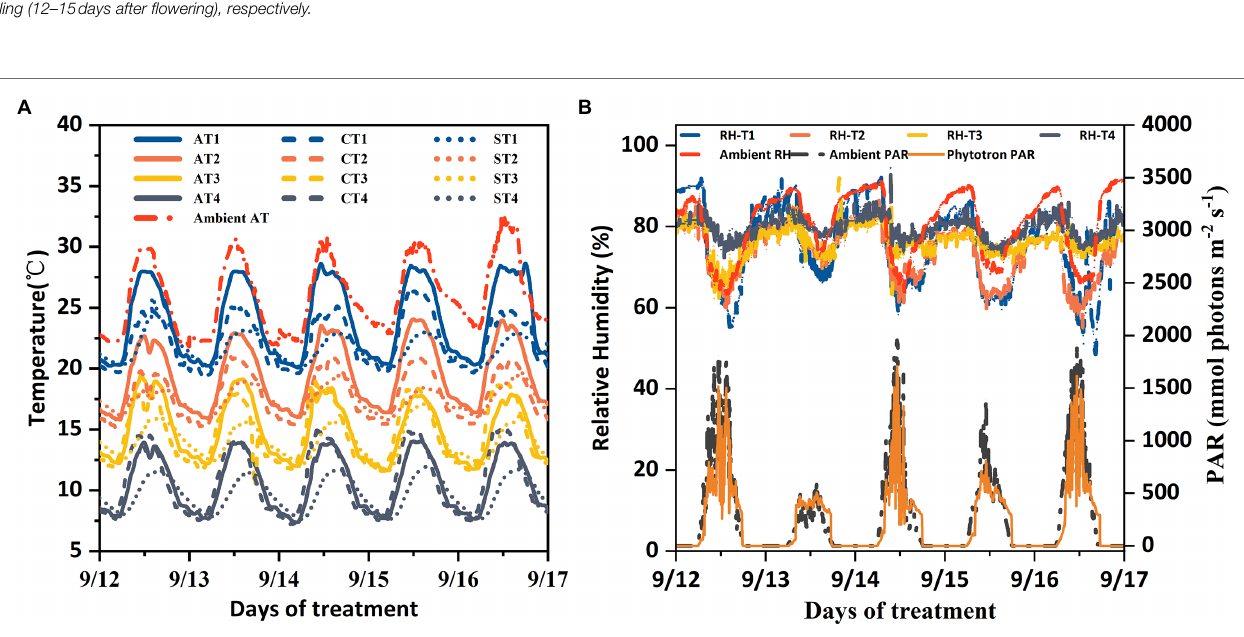
FIGURE 1 | Diurnal changes of four levels of air temperature (AT; A , solid lines), canopy temperature (CT; A , broken lines), soil temperature (ST; A , dotted lines), relative humidity (RH; B , broken lines), and incident photosynthetically active radiations (PAR; B , solid line) measured in low-temperature stress treatment chambers in 2018. Lines with double dots show the ambient AT, PAR, and RH of the same